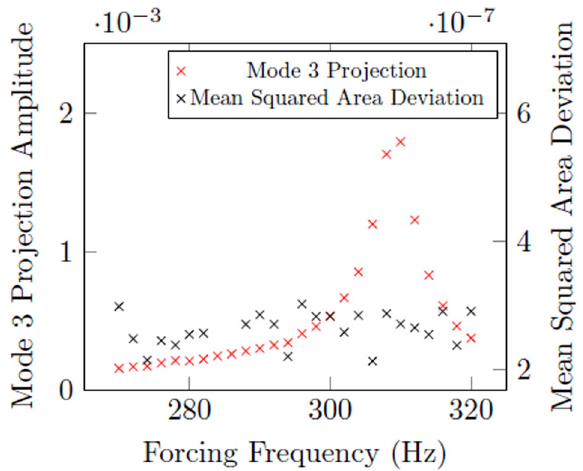
Fig. 8 Comparison of results from an area array and projection method for mode 3 resonance. Sample is 57.345 mg Inconel 625 at 1350 ∘ droplet most strongly deforms must be slightly shifted by a factor δ f / f (given by Eq. (8)) from its true natural frequency given by Eq. (1) and decrease the accuracy of the surface tension measurement.